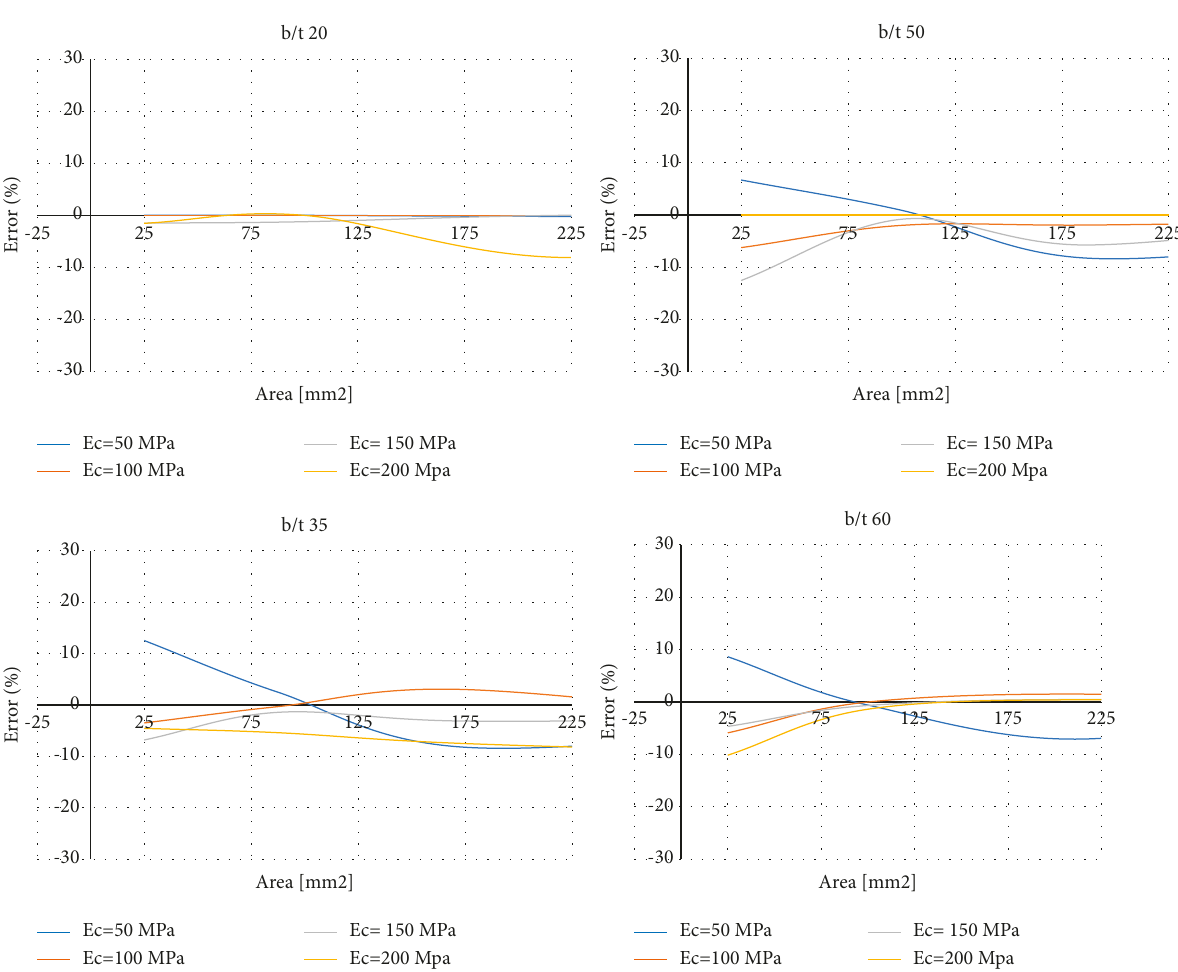
Figure 17: The error of the simplified formula in the case of the outstand plate.